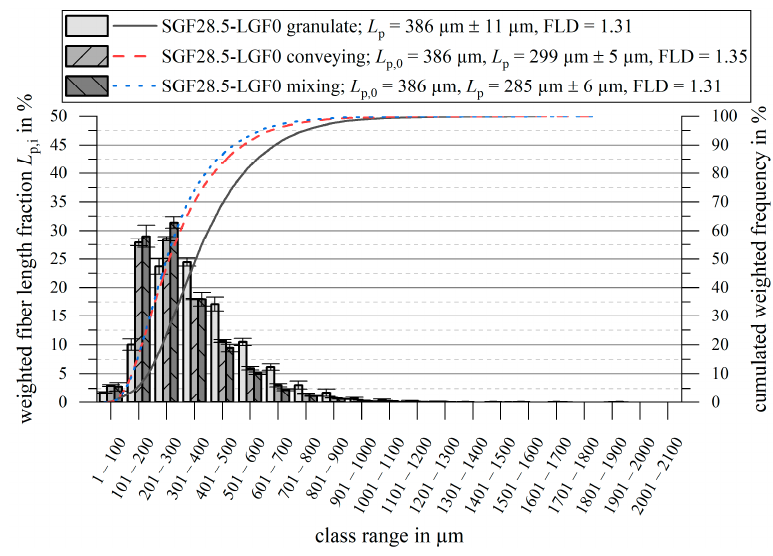
Figure 15. Fiber length measurement results for PF-SGF28.5-LGF0.